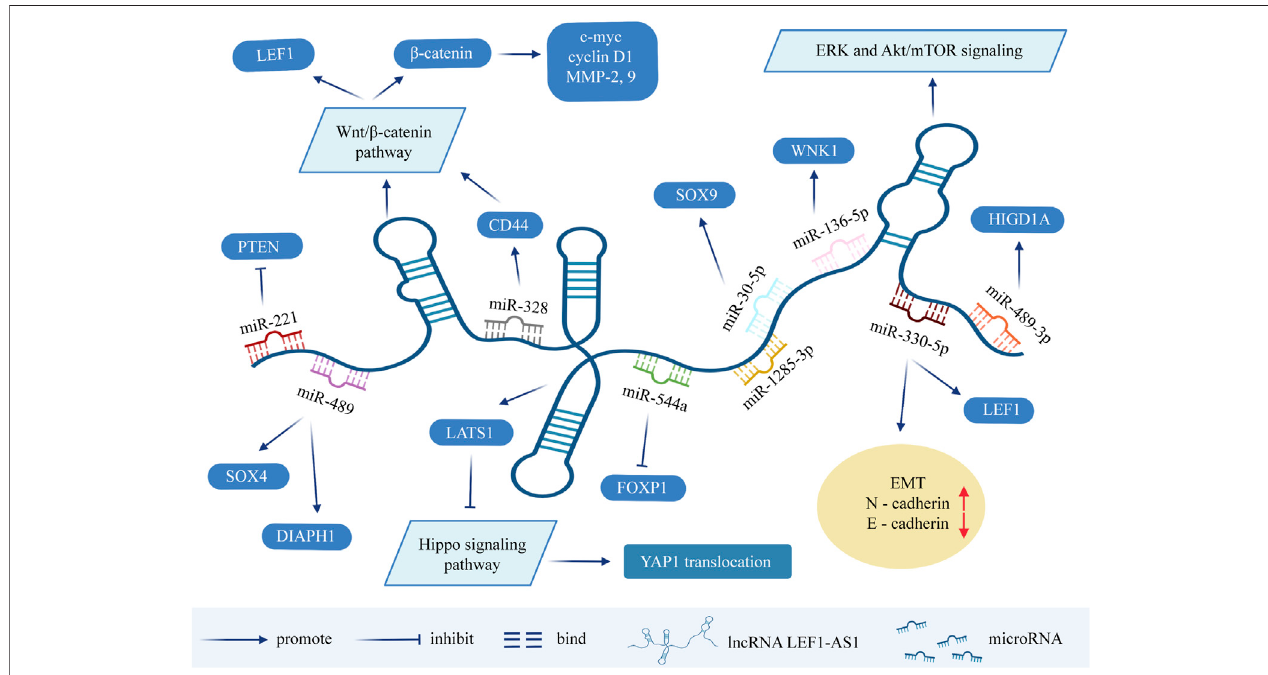
FIGURE 2 | Molecular mechanisms and related signaling pathways of lncRNA LEF1-AS1 in cancers. MicroRNA can cause gene silencing by binding to mRNA, whileceRNAcanregulategeneexpressionbycompetitivelybindingtomicroRNA.LEF1-AS1canbeusedasceRNA,spongemiRNA,therebyaffectingtheexpressionof target genes. LEF1-AS1 also participates in signaling pathways such as ERK and Akt/mTOR signaling pathway, Wnt/ β -catenin pathway, and Hippo signaling pathway. Abbreviations: LEF1-AS1, lymph enhancer-binding factor 1-antisense RNA 1; ceRNA, competing endogenous RNA; EMT, epithelial-mesenchymal transition.